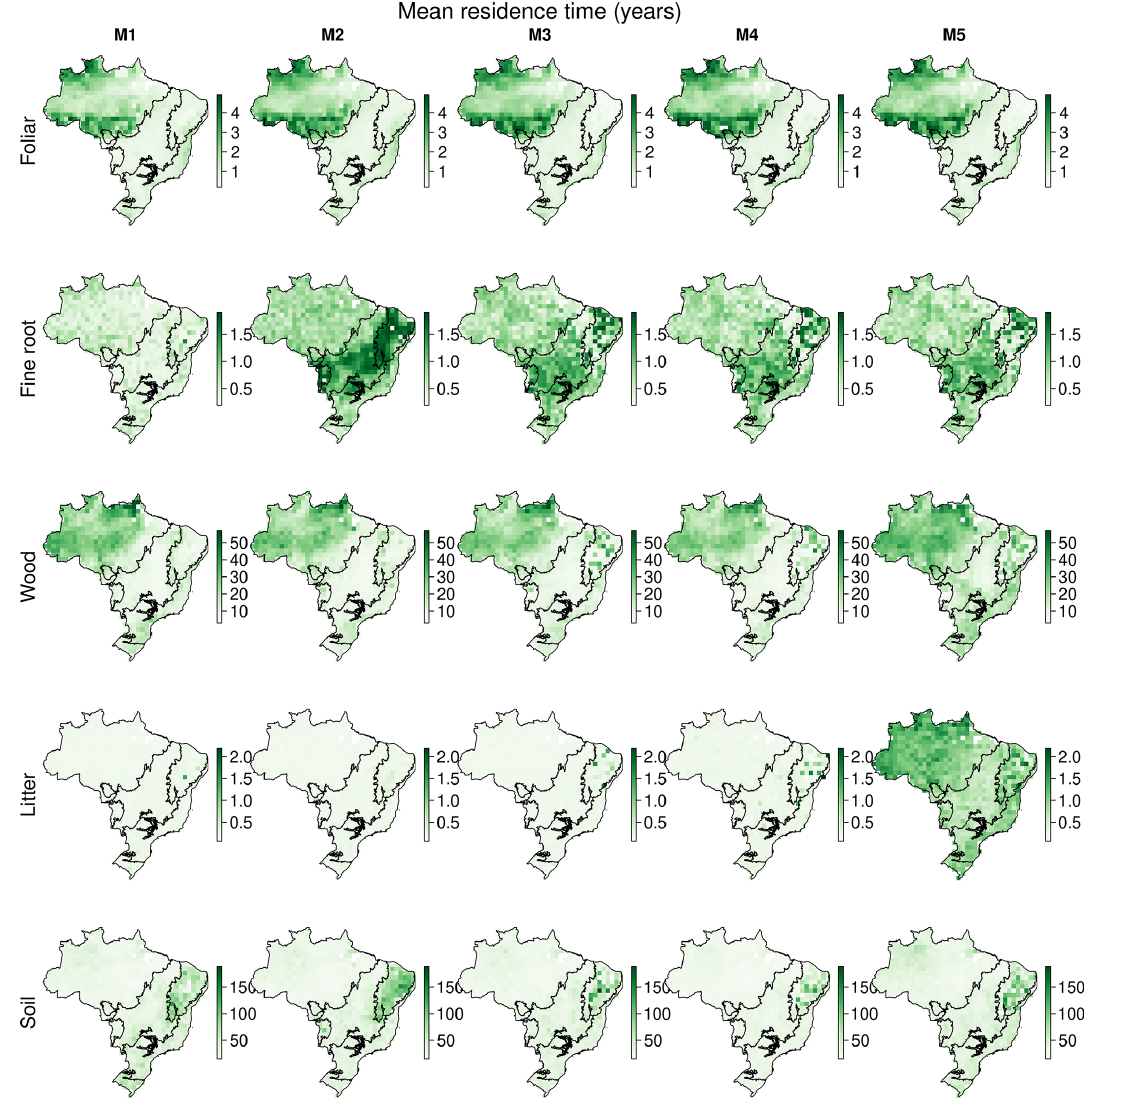
Figure A13. Maps showing the localised median estimates of carbon pool MRTs for each model. Note that for models M1–4 litter MRT is foliar and fine root litter, while M5 also includes wood